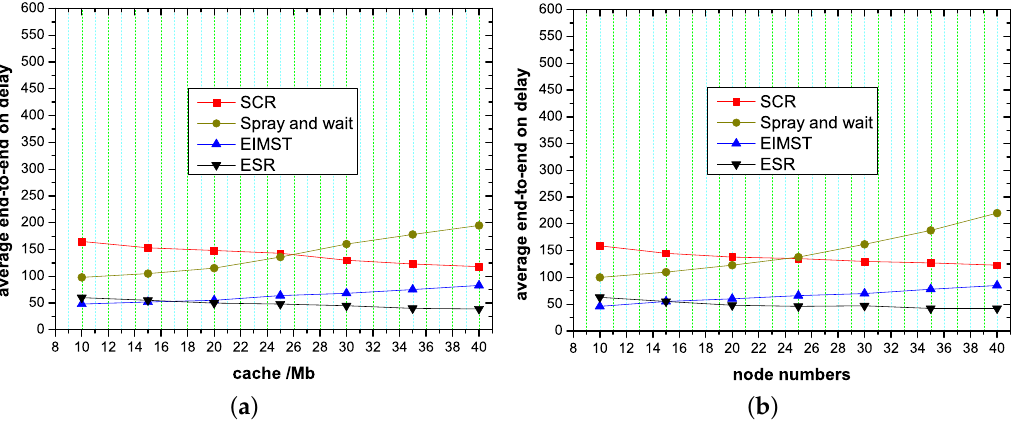
Figure 6. The average end-to-end transmission delay of ESR algorithms, EIMST algorithm, Spray and wait algorithm and SCR algorithm when at different node cache sizes and number of nodes. ( a ) The effect of node cache on transmission delay; ( b ) The effect of node numbers on transmission